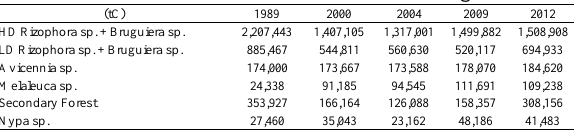
Figure 7. Estimation of carbon stock change Table 6. Estimation of carbon stock